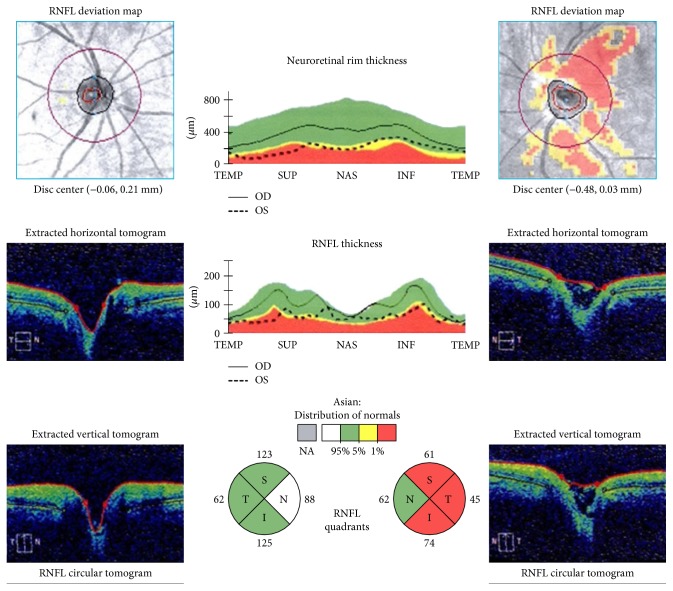
Peripapillary retinal nerve fibre layer (pRNFL) thickness measured by OCT. Temporal pRNFL was significantly reduced in eyes with BCVA < 20/400, (p < 0.05).